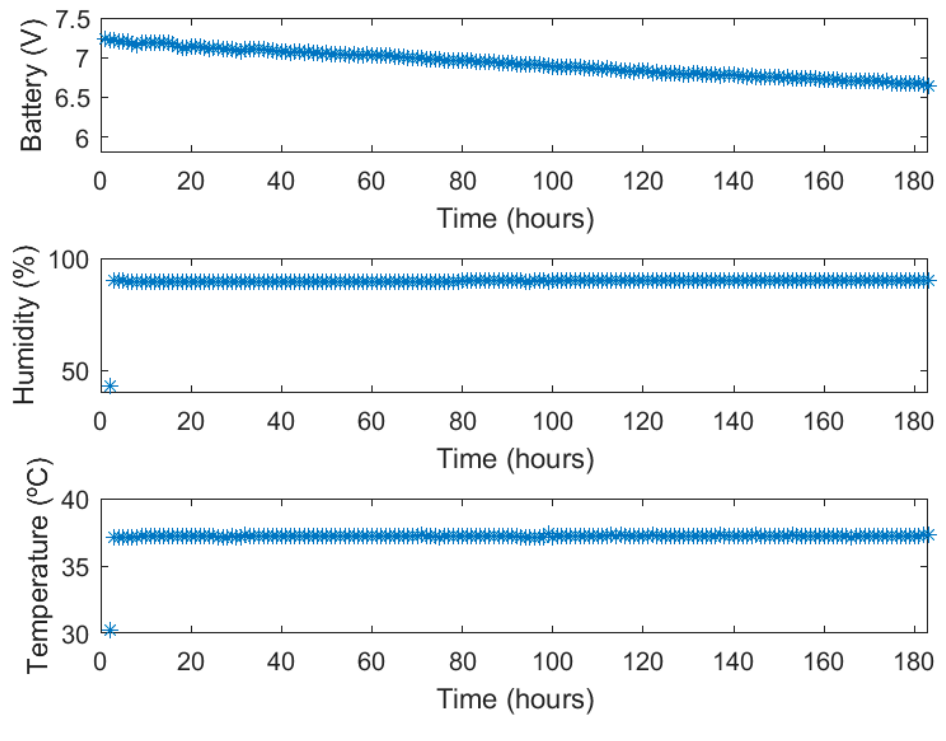
Figure 9. Battery voltage, relative humidity and temperature graphs.